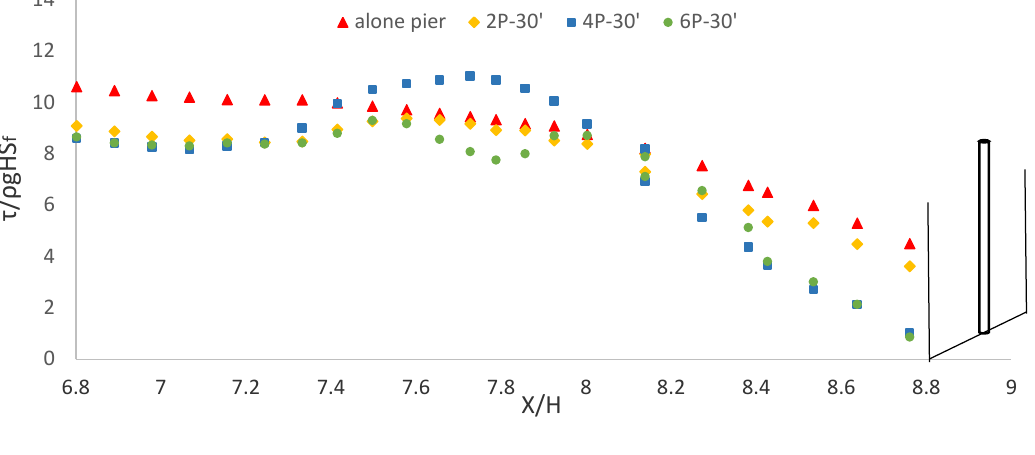
Fig 19. Shear Stress Distribution in 𝛼 = 30˚ , 𝑍 =